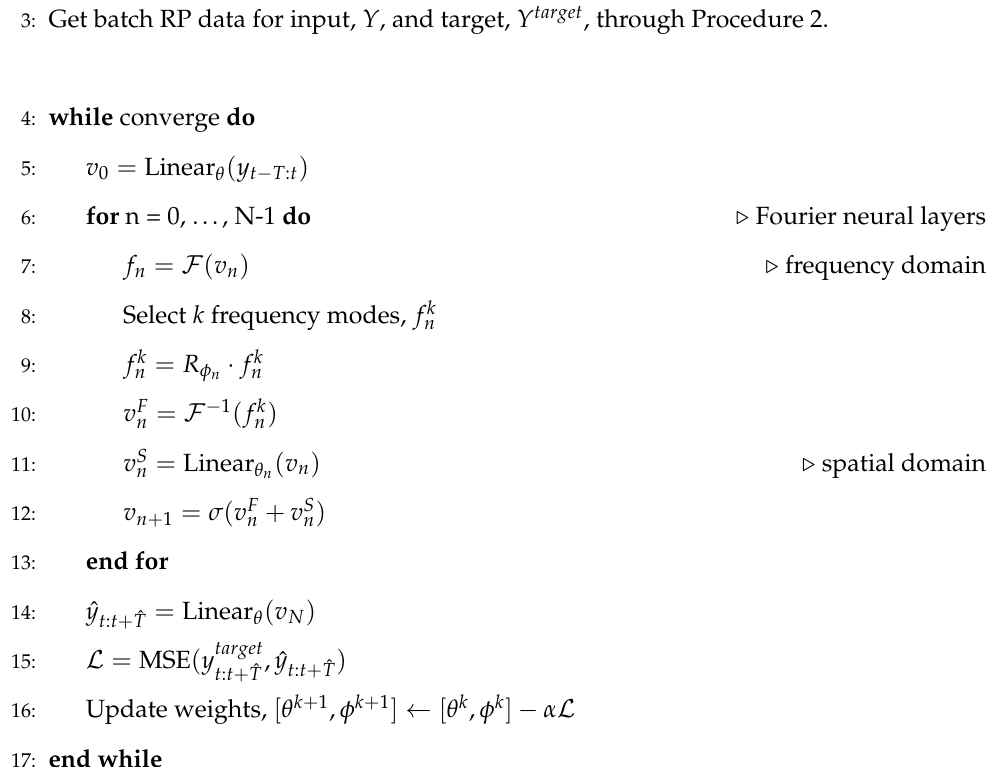
Procedure 1 : Procedure for Performing Fourier Neural Operator